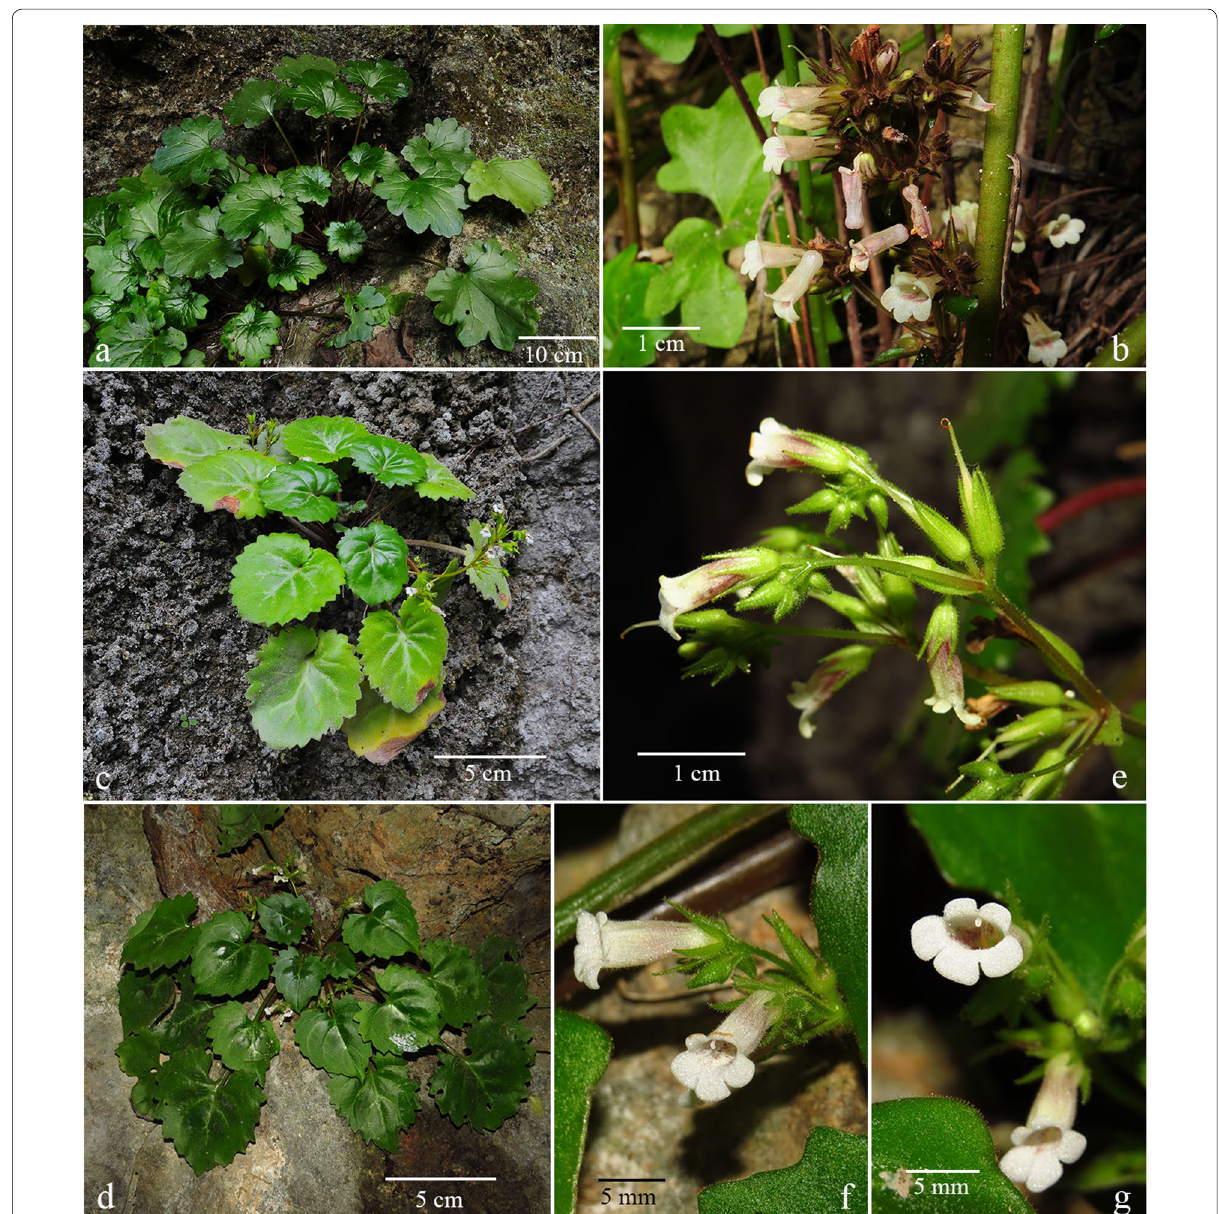
Fig. 13 Primulina glandulosa (D.Fang, L.Zeng & D.H.Qin) Yin Z.Wang ( a , b ) and Primulina pseudoglandulosa W.B.Xu & K.F.Chung ( c – g ). a habit, b inflorescences; c , d habit, e inflorescences, f flowers (side view), g flowers (face view). a , b from type locality of Chiritopsis glandulosa D.Fang,